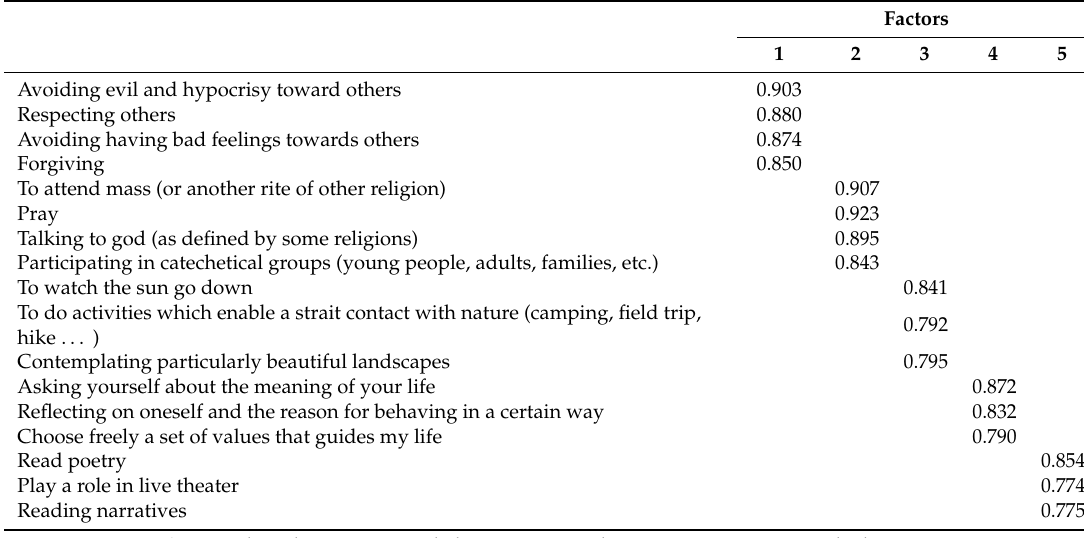
Table 1. Factor loadings for the five-factor structure in the Exploratory Factor